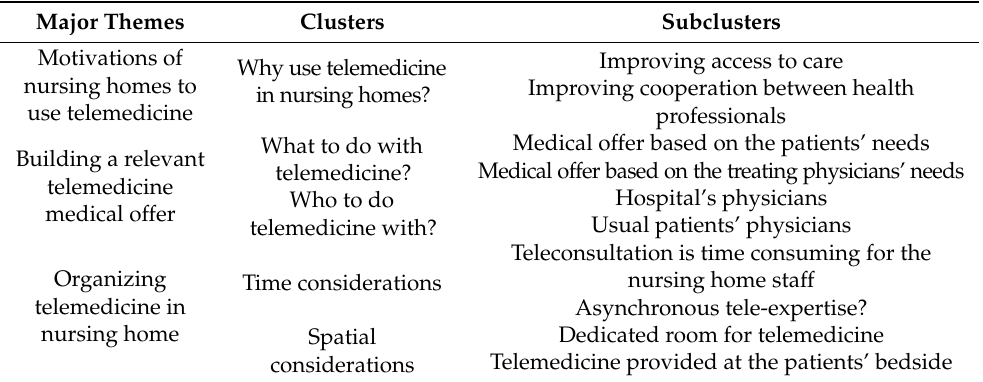
Table 5. Summary of the overall themes derived from the interviews and their clustering of nursing home using